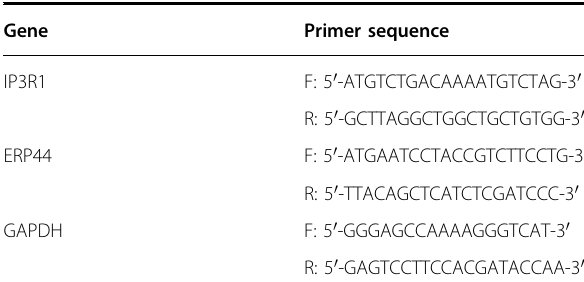
Table 1 Primer sequences of RT-qPCR. Gene Primer